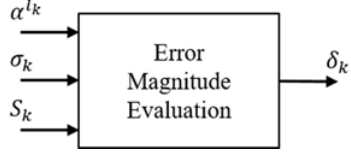
Figure 3. Error magnitude evaluation block.